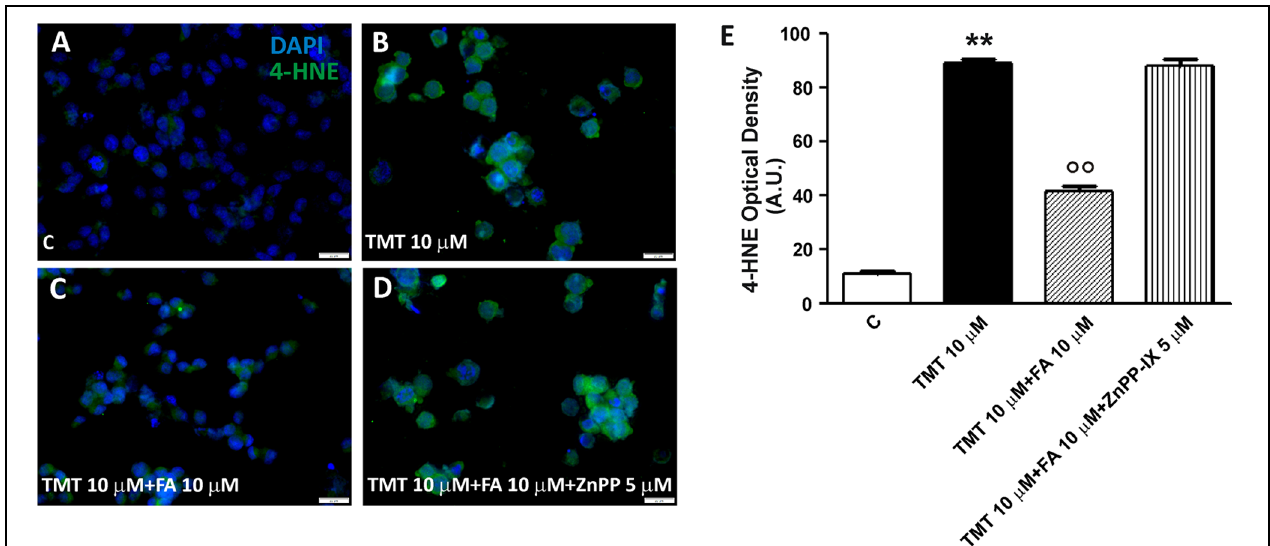
FIGURE 7 | Ferulic acid inhibits lipid peroxidation through the HO activity. (A–D) Representative immunofluorescence images of SH-SY5Y cells treated with TMT (10 μ M), FA (10 μ M), and ZnPP-IX (5 μ M) double stained with DAPI (blue) and an anti-4-HNE antibody (green). 4-HNE labeling was faint in control cells (A) . After TMT treatment, a remarkable increase of 4-HNE fluorescence was detected (B) . The combined treatment with TMT and FA decreases significantly lipid peroxidation (C) whereas, when cells were treated with TMT and FA and ZnPP, 4-HNE labeling remains marked similarly to the result observed in TMT treated cells (D) . (E) Bar graphs (mean ± SEM) showing optical density quantification in treated cells for 4-HNE labeling. Data are representative of three independent experiments; each count was performed on five fields randomly selected for each experimental condition. Scale bar (A–D) 20 μ m. For further information see text. ∗∗ P < 0.01 vs. controls (C) , ◦◦ P < 0.01 vs.